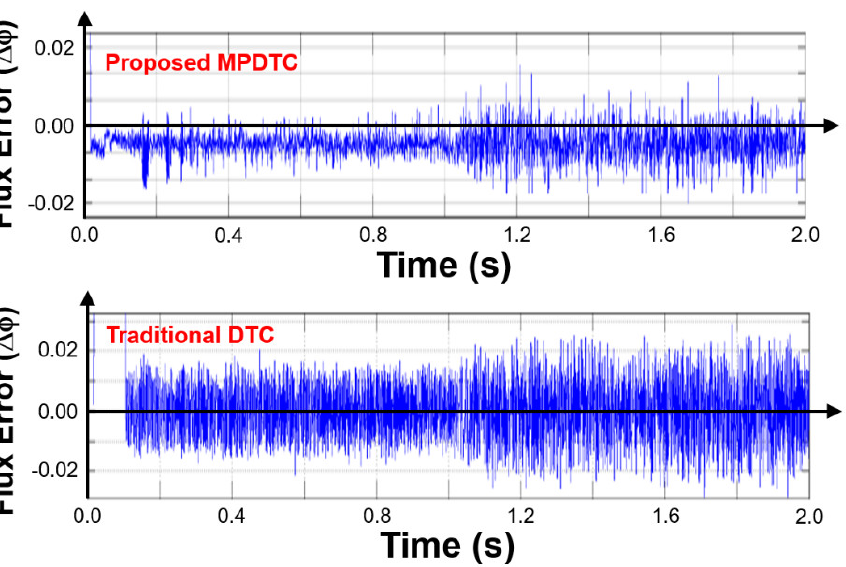
Figure 13. Simulated flux errors of the proposed MPDTC and traditional DTC systems between 0 and 2 s.